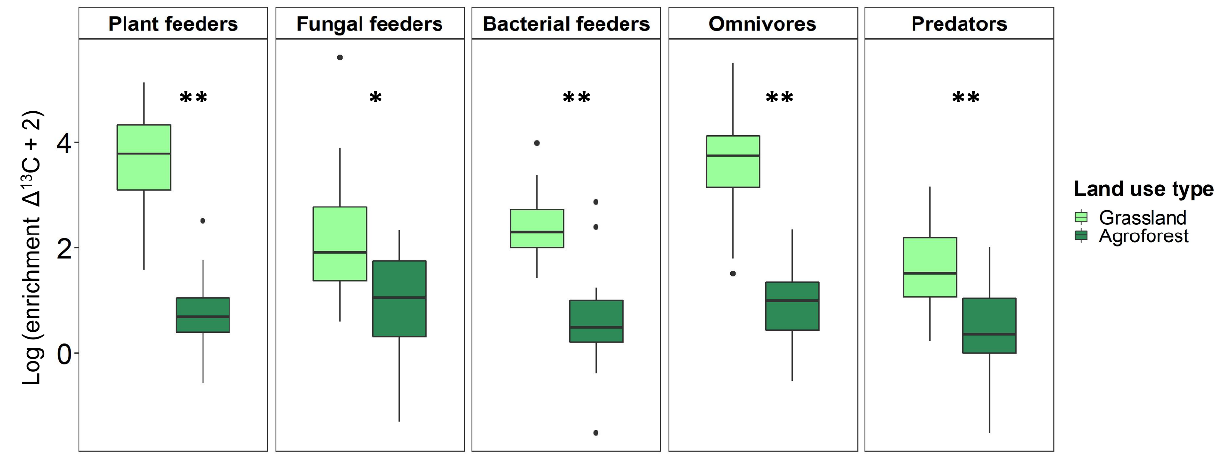
Figure 3. Comparison between the enrichment with 13 C [(log( ∆ 13 C + 2) in‰] of nematode trophic groups in grassland and agroforest soils. All sampling dates (i.e., 3, 7, 14 and 28 days after 13 CO 2 labeling) are bulked together. Two-sample t -test with * , ** at p < 0.01, 0.001.